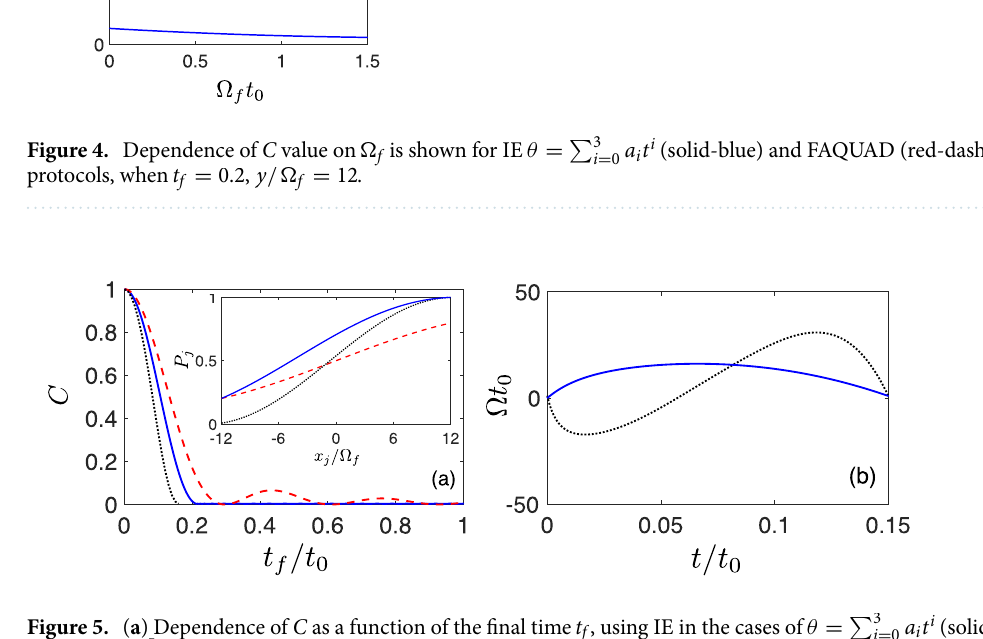
Figure 5. ( a ) Dependence of C as a function of the final time t f , using IE in the cases of θ 5 i (dotted-black) and FAQUAD (dashed-red). The inset of ( a ) shows the corresponding blue), θ 0 a i t i = 0.15 , where the dotted-black curve represents the quasi-optimal-time solution = transfer functions for t f = (cid:31) 3980 . ( b ) For t 0.15 , the driving field �( t ) designed from IE in the cases of using 50 , a 3 with a 2 f = 3 5 = − = − i (solid-blue), using θ i with the optimal parameters a 2 θ 0 a i t 0 a i t i i = = 12 = = black), and y /� f = (cid:31) (cid:31)